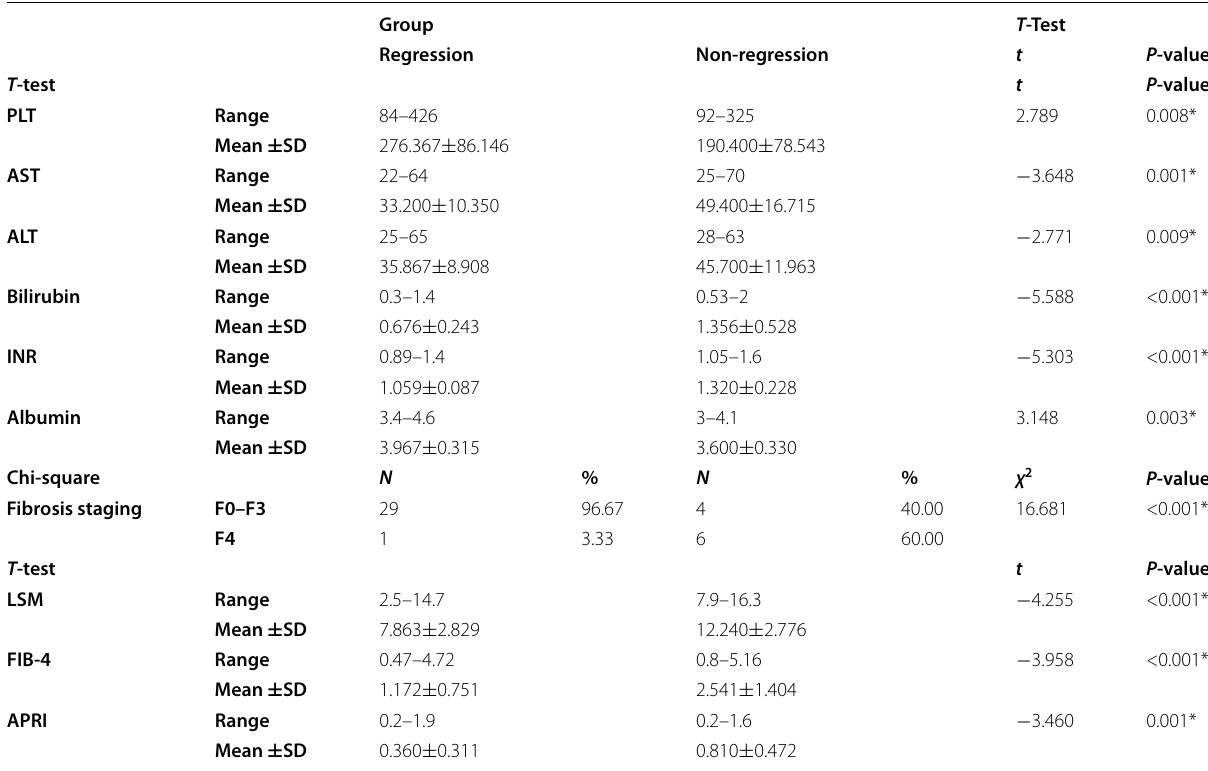
Table 9 Comparison between patients with and without fibrosis regression regarding different laboratory parameters, liver stiffness,